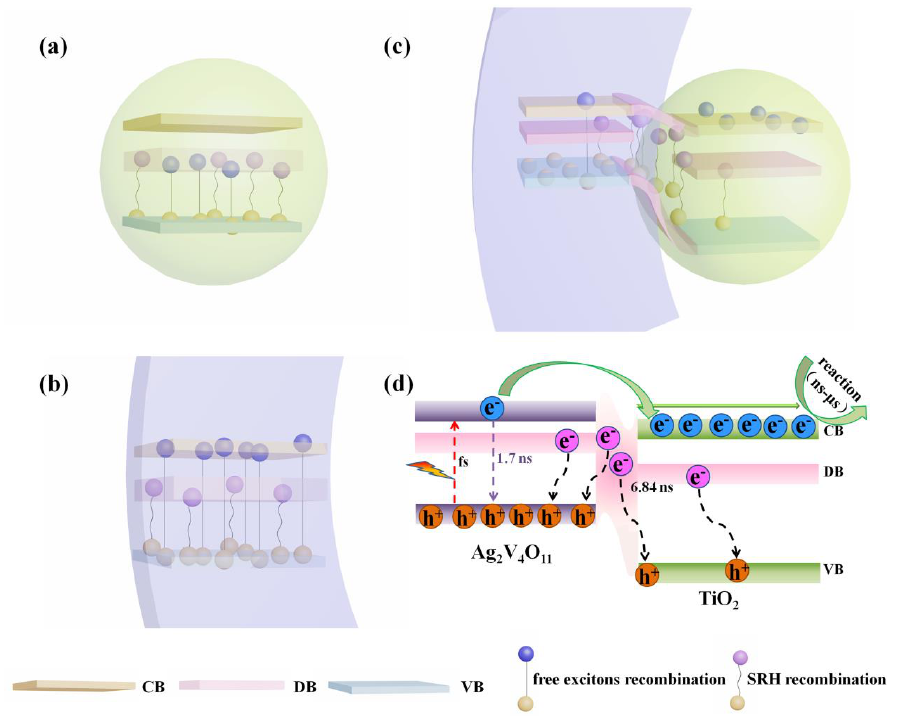
Figure 11. Schematic illustration of the carrier recombination kinetics occurred in the conduction band (CB), defect band (DB), and valence band (VB) of the ( a ) T, ( b ) A, and ( c , d ) TA samples, respectively.